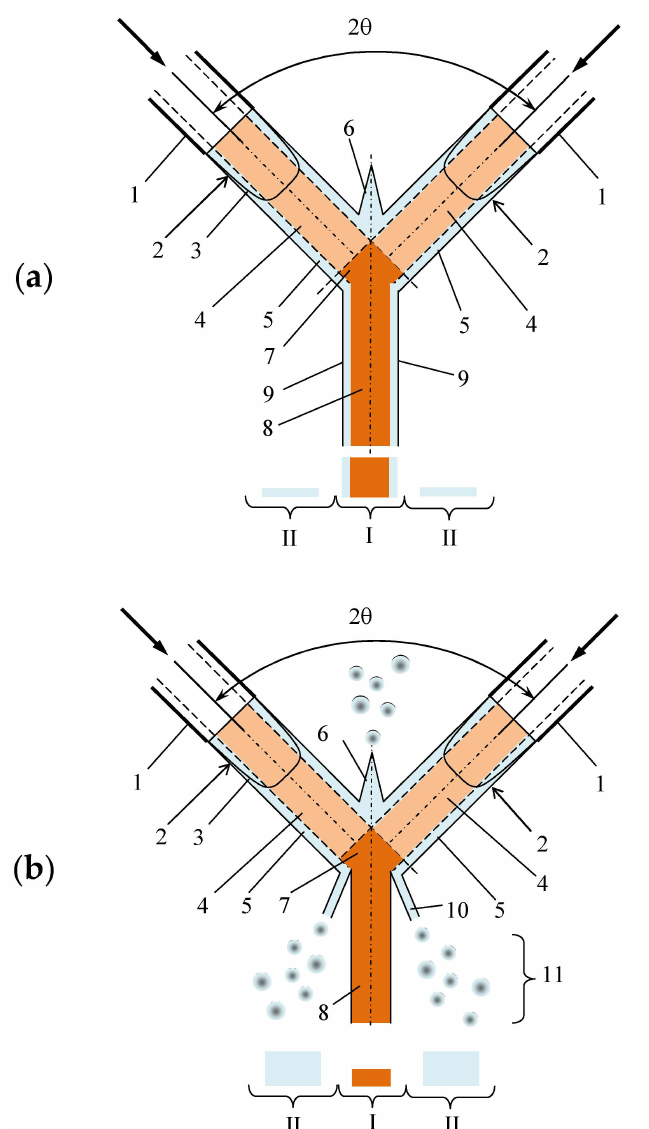
Figure 8. Schematic view illustrating a mechanism for separating the mixture into zones of intense and poor micromixing: 1—nozzle; 2—jets; 3—velocity profile at the nozzle outlet; 4—stream core (central zone of jets); 5—wall laminar layer (annular zone of jets); 6—the upper part of the liquid sheet; 7—zone of collision of flow cores; 8—core of the lower part of the liquid sheet; 9—outer layers of the lower part of the liquid sheath; 10—side ligaments; 11—drops. Flow rates: ( a )— Q j < 700 mL / min; ( b )— Q j ≥ 700 mL / min. I-central sampling area; II—peripheral sampling area. Orange—the sample with good micromixing, blue—the sample with poor